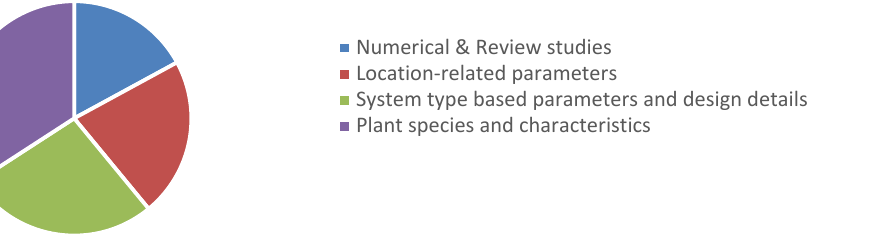
Figure 1. The distribution of the total number of articles reviewed in the study according to the analysis groups.